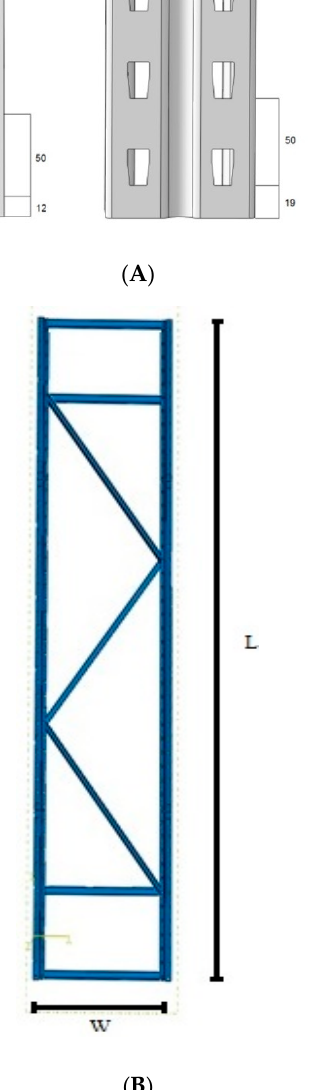
Figure 2. Configuration of the details: ( A ) Upright configuration; ( B ) Frame configuration.